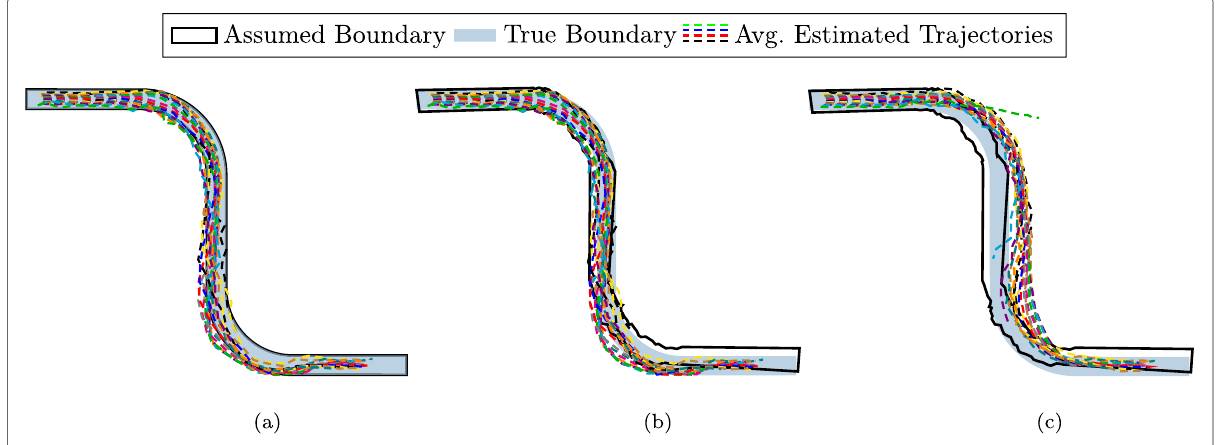
Fig. 13 Averaged trajectories (dashed lines) with different levels of EU and the assumed (meshed) environment in blue for L θ = 750, L = 316. a No EU ( σ EU = 0), b , c with EU and assumed environment boundary visualized by black